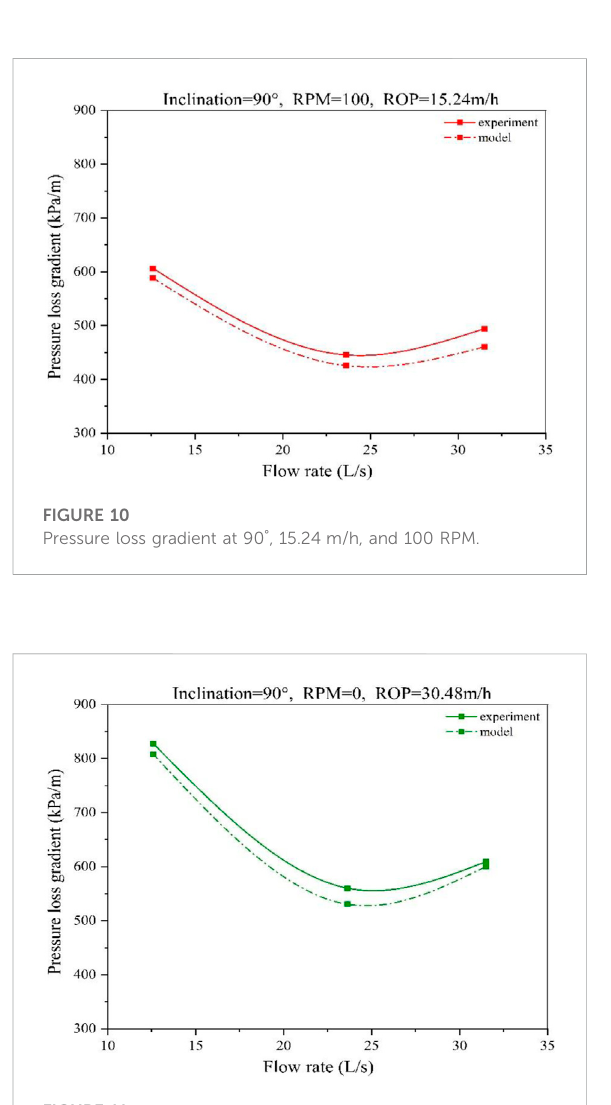
FIGURE 11 Pressure loss gradient at 90 ° , 30.48 m/h, and 0 RPM.